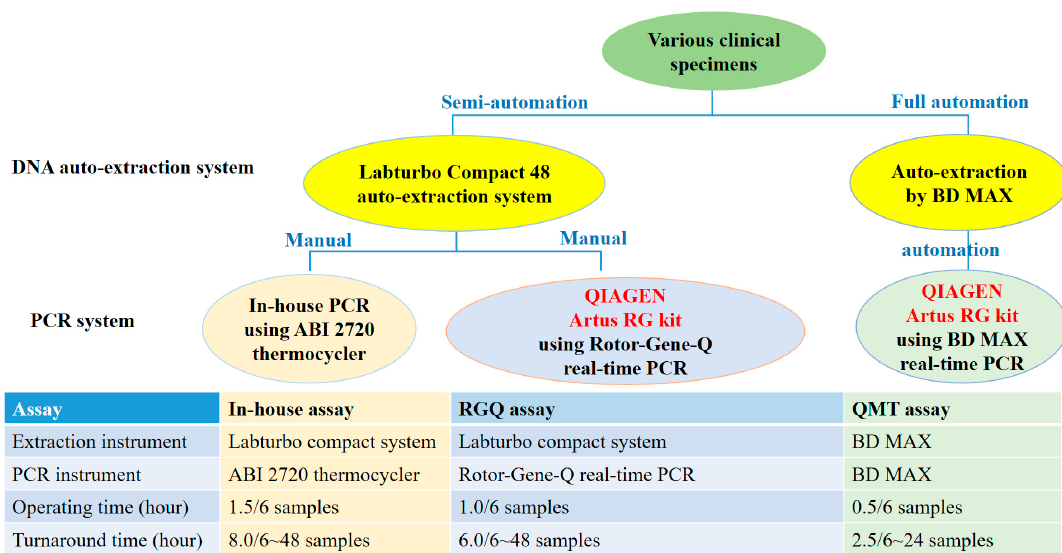
Figure 1. Comparative workflows for the in-house, RGQ, and QMT assays for detection of cytomegalovirus (CMV) nucleic acid in various clinical specimens. Maximum 24 samples for QMT assay vs. 48 samples for the others two assays in one batch.